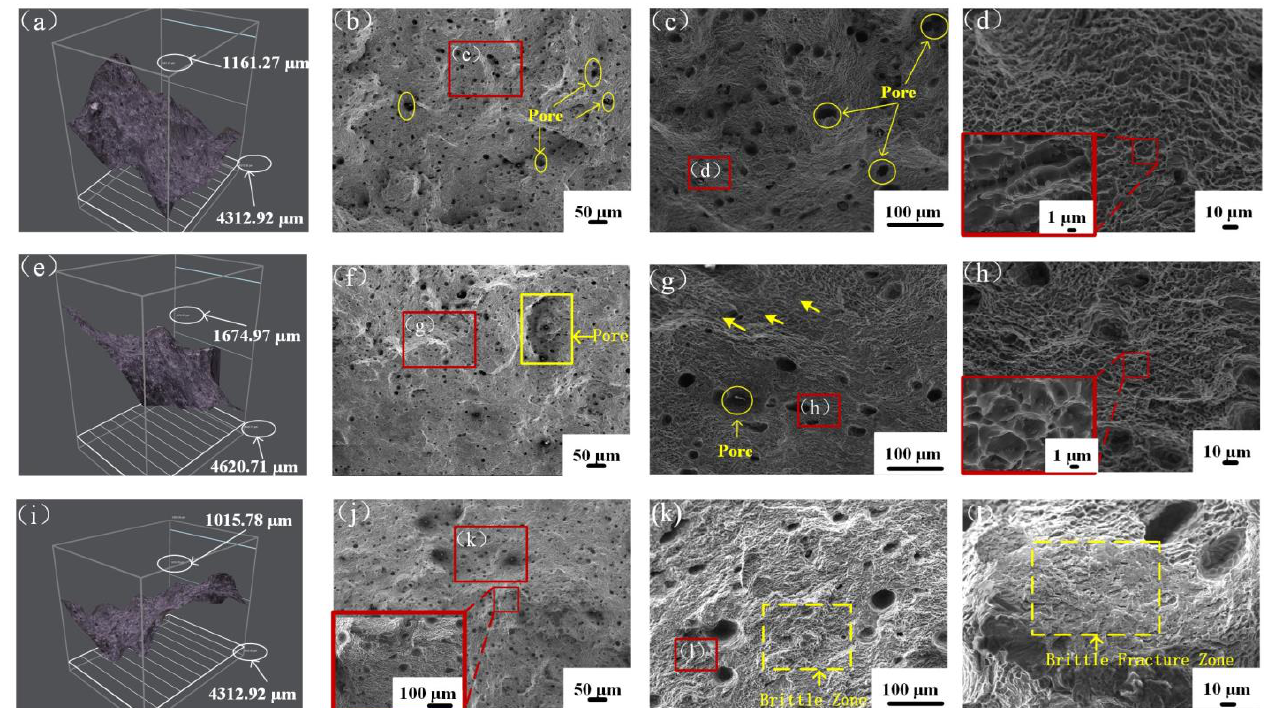
Figure 8. Fracture morphology of 4043 aluminum alloy: ( a – d ) top area, ( e – h ) middle area, and ( i – l ) bottom area.